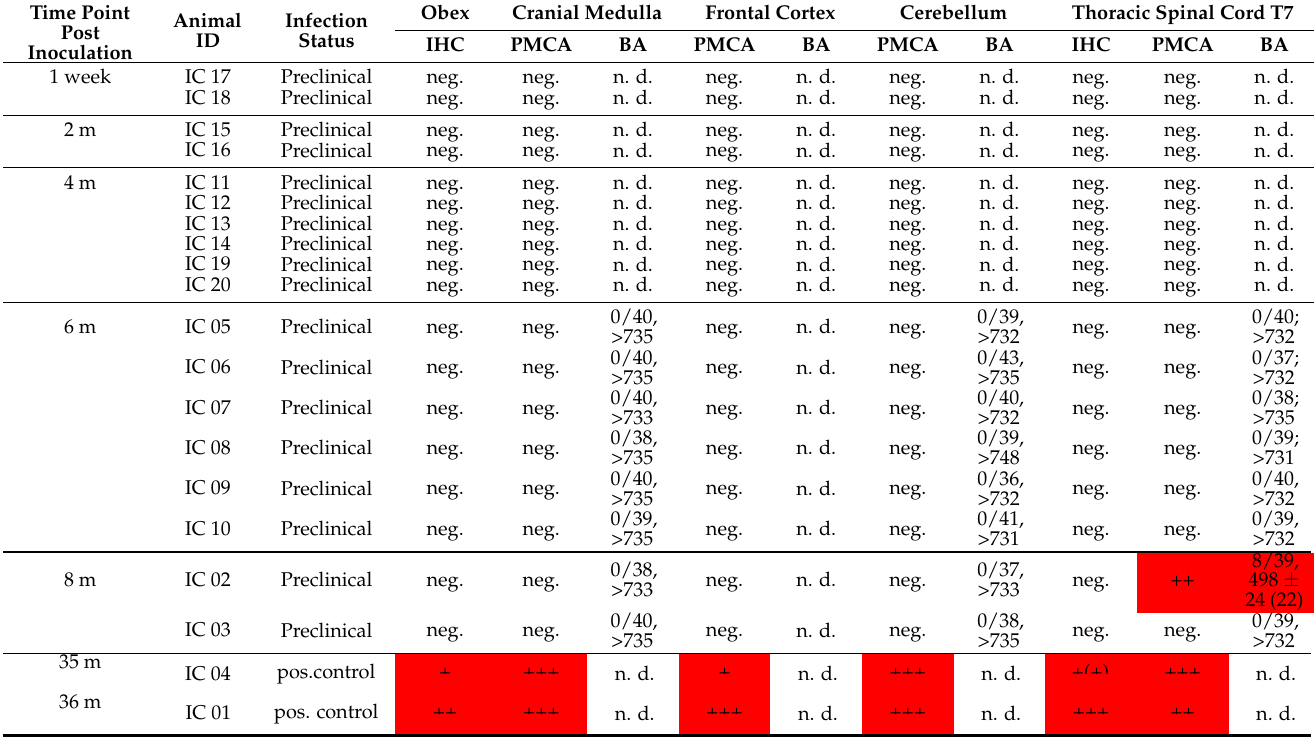
Table 3. Results obtained for samples of the central nervous system together with the clinical status of all challenged calves. Time Point Post Inoculation